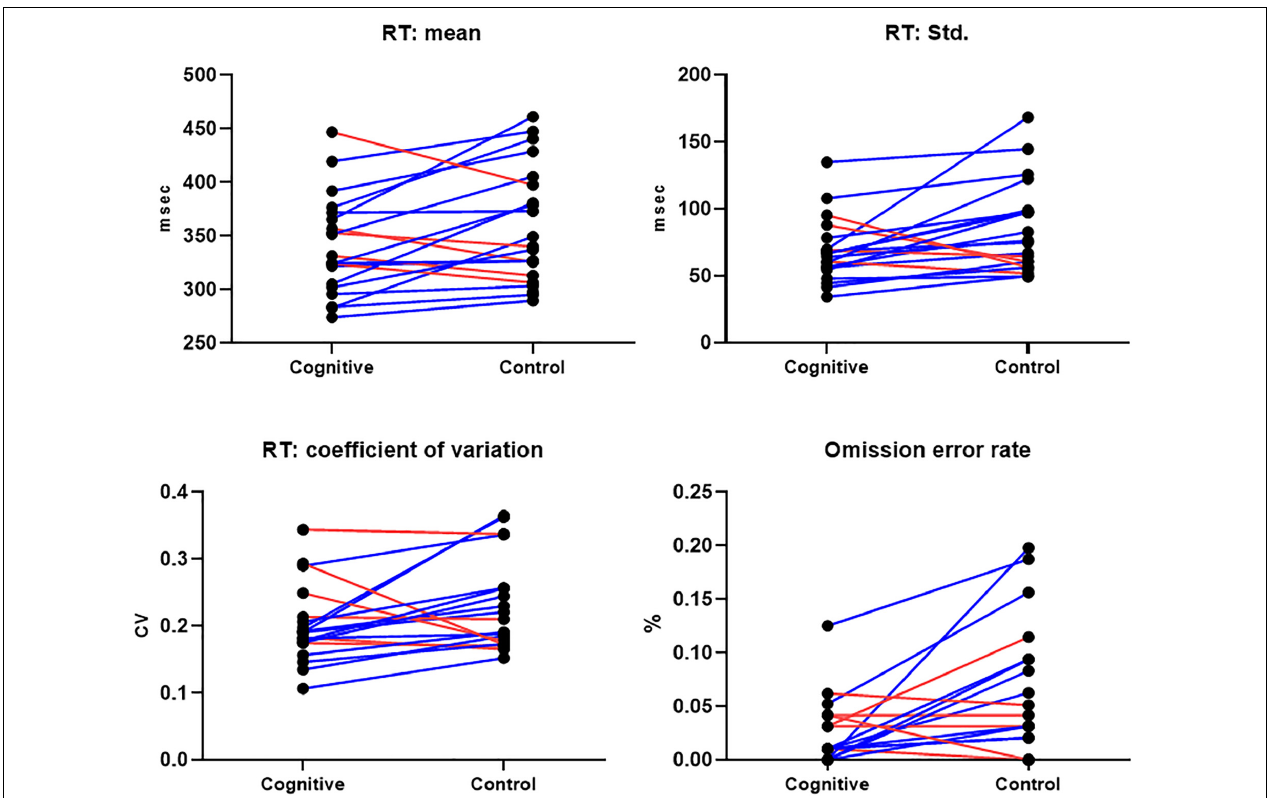
FIGURE 9 | CPT Results, MPH-Cognitive induction condition vs. MPH-Control induction condition. Upper panel: Response time mean and standard deviation, per -participant, per -condition. Lower panel: Coefficient of variation (standardized measure of dispersion) and omission error rate, per -participant, per -condition. In all presented measures, participants performed better on average in the MPH-Cognitive induction condition compared with the MPH-control induction condition. Blue lines represent participants who performed better in the MPH-Cognitive condition, while red lines represent participants who performed better in the MPH-control